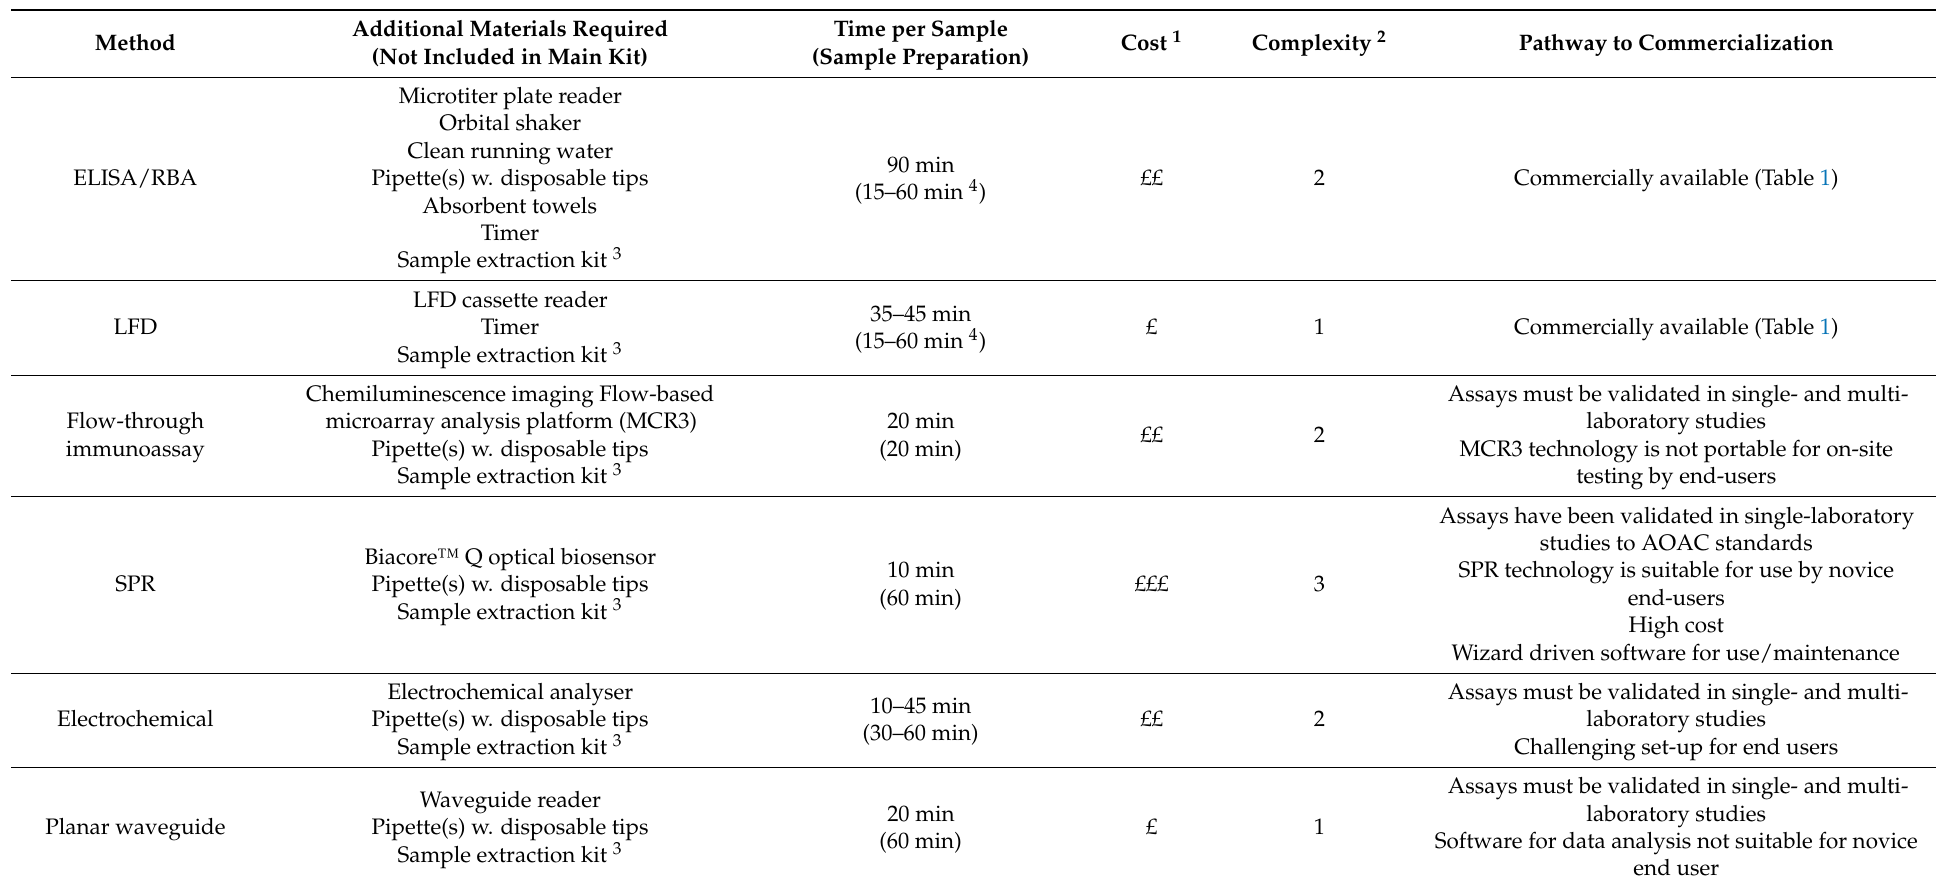
Table 2. The list of available end-product testing